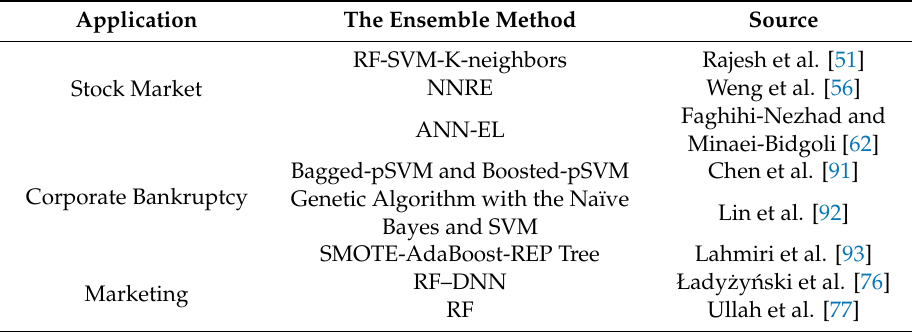
Table 11. List of ensemble models applied in the database on the current